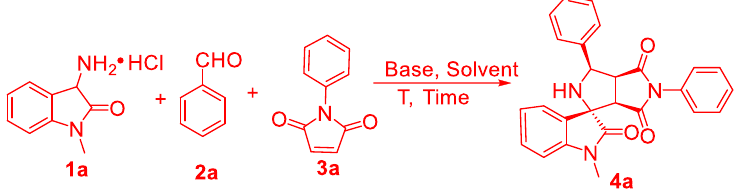
(Table 1, entry 17). Scaling up reaction did not result in the loss of the reactivity and diastereoselectivity (Table 1, entry 18). Molecules 2018 , 22 , x 3 of 13